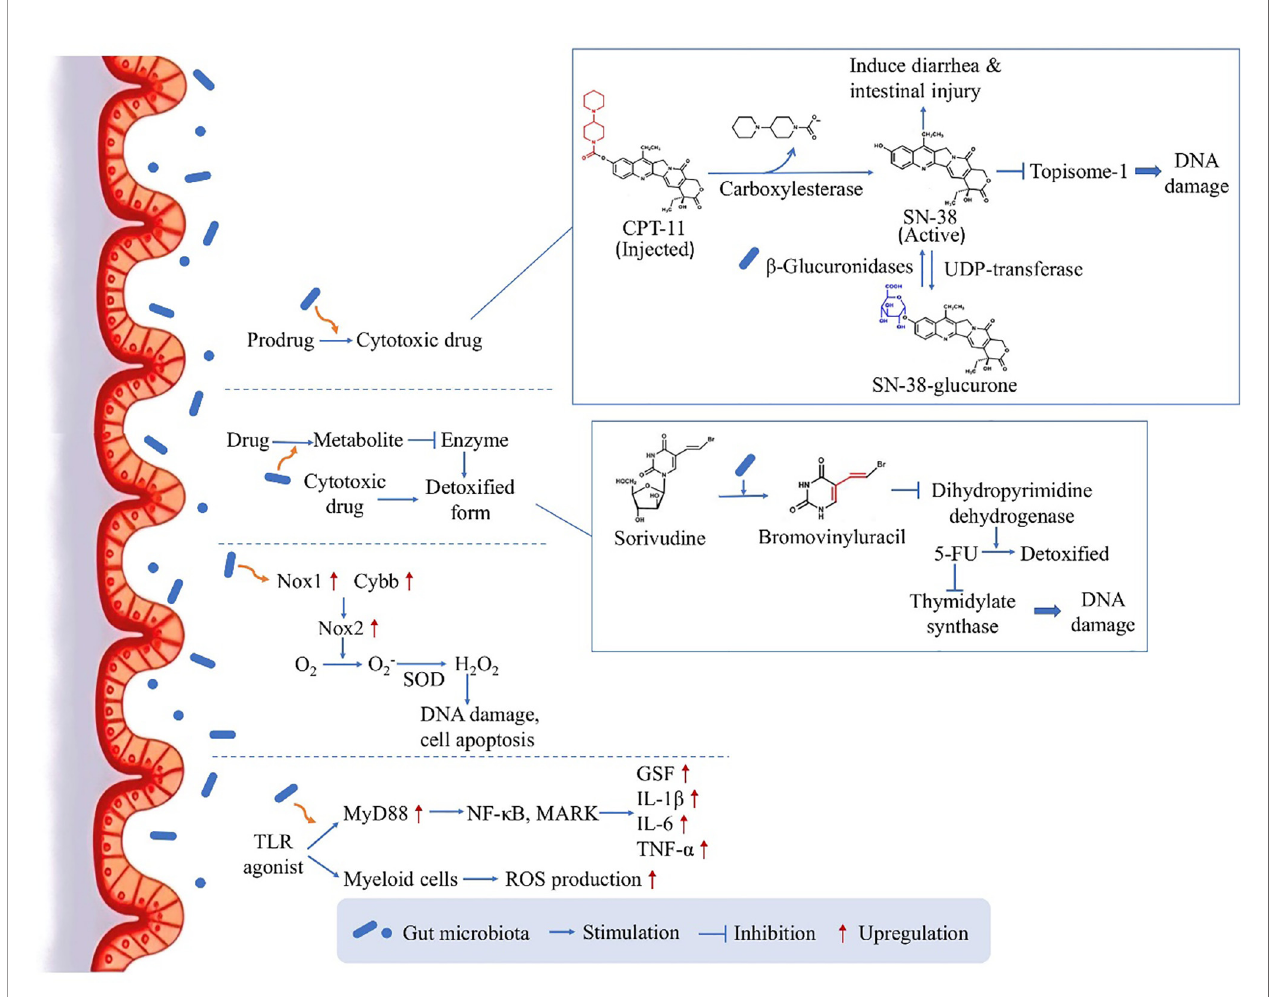
FIGURE 1 | The direct in fl uence of microbiota on chemotherapy: drug pharmacokinetics and ROS production. By several mechanism pathways, the gut microbiota can directly act on the drug conversion and gene transcription, leading to an either enhanced therapeutic effect or enhanced side